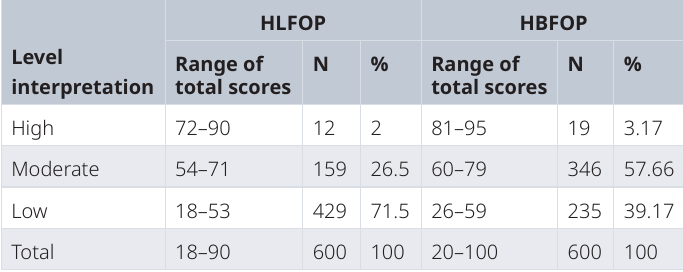
Table 1. The levels of health literacy for obesity prevention (HLFOP) and health behavior for obesity prevention (HBFOP) for school aged children in Thailand.